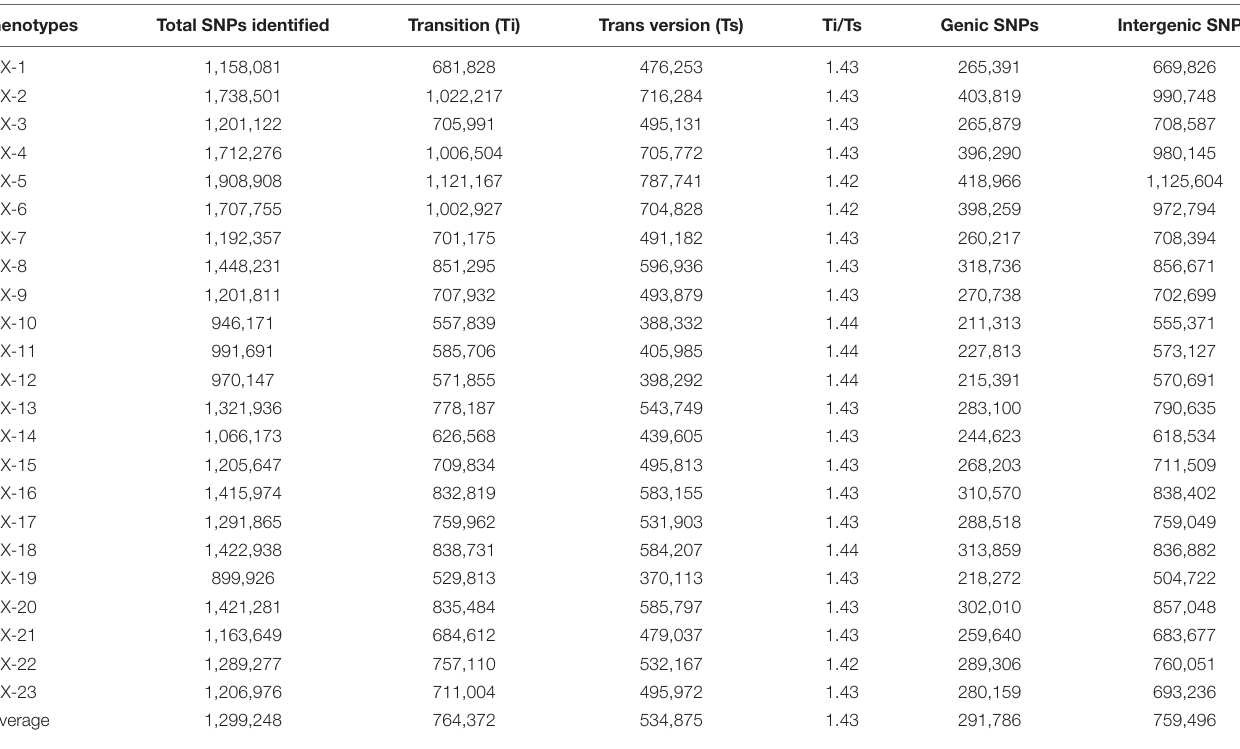
TABLE 2 | Statistics on single nucleotide polymorphisms (SNPs) identified between the samples and the reference.